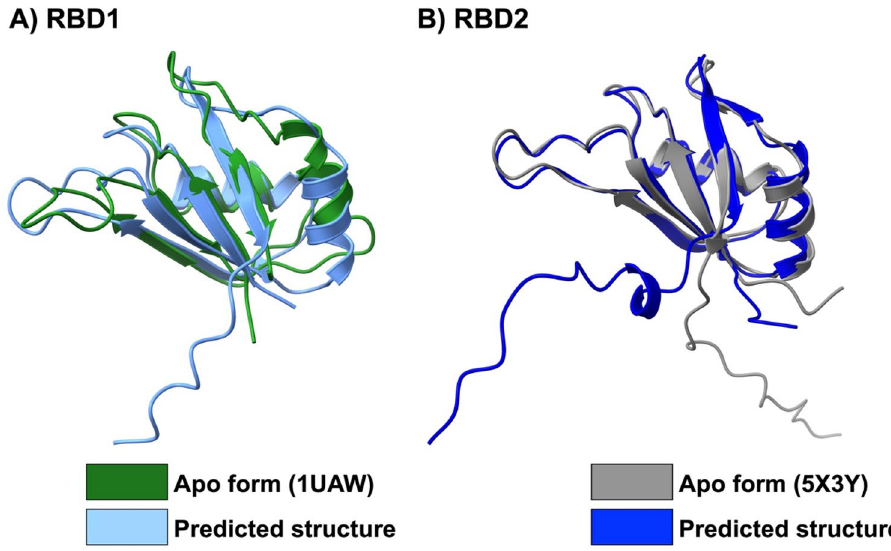
Figure 2. Superimposition of ( A ) MSI1–RBD1 and ( B ) MSI1–RBD2 from NMR structures in apo form and the predicted structure from Alphafold2.